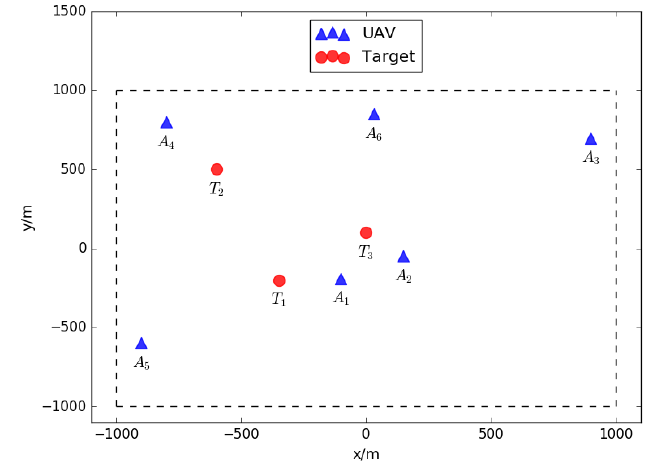
Figure 15. The initial positions of targets and UAVs.